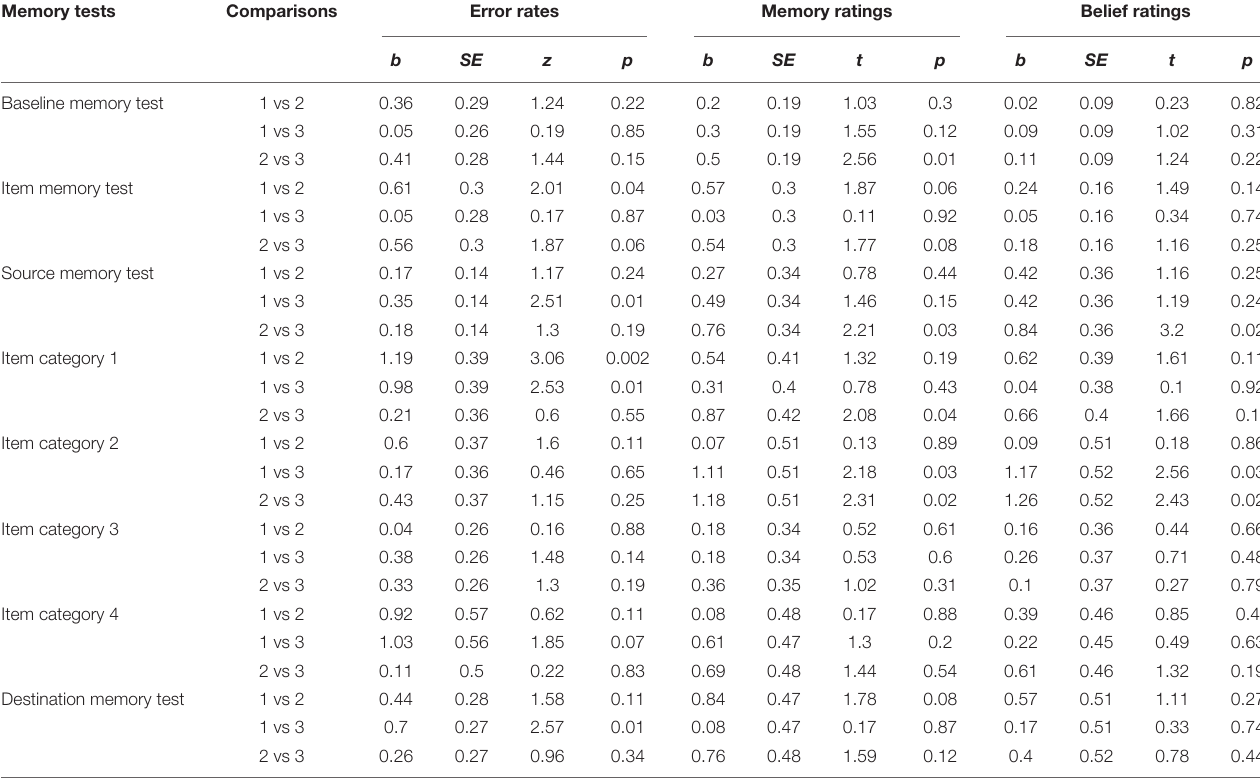
TABLE 2 | Inferential statistics for each comparison and memory